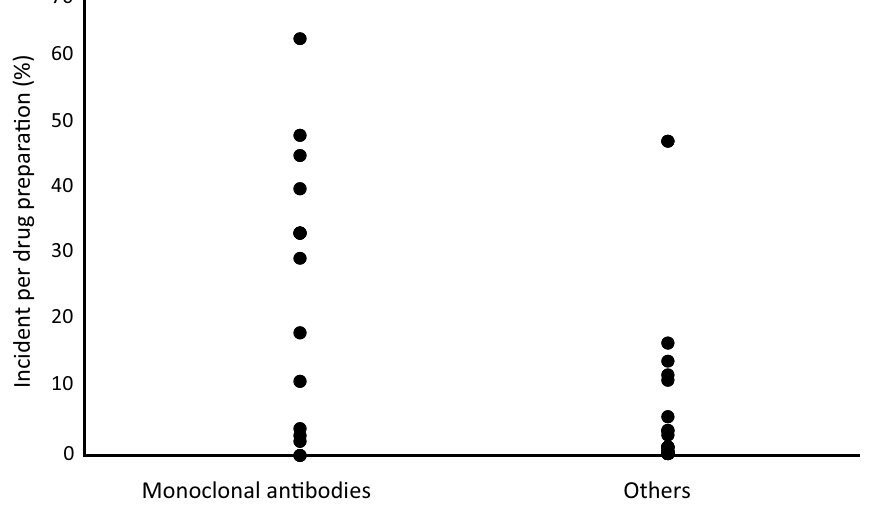
Figure 1. Frequencies of insoluble fine particles in preparation of monoclonal antibodies compared to those during preparation of cytotoxic agents at Ehime University Hospital. Others: all anticancer agents excluding monoclonal antibodies.